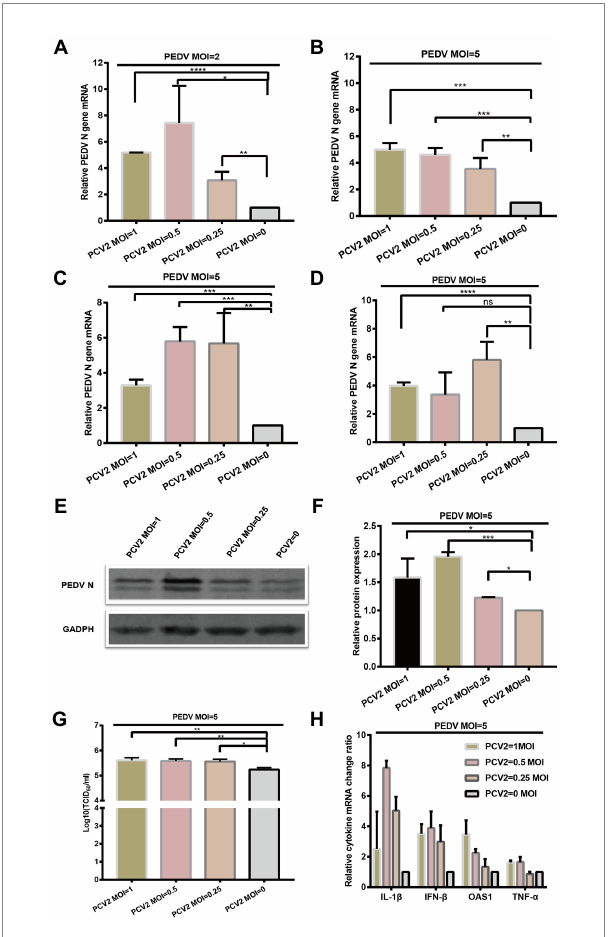
FIGURE 5 PCV2 promotes PEDV replication in IPI-FX cells. IPI-FX cells were inoculated with PEDV (MOI = 2 or 5) and simultaneously with PCV2d- LNHC (MOI = 1, 0.5, or 0.25). The cells were collected, the total RNA extracted, and the relative expression levels of nucleocapsid (N) mRNA in the PEDV–PCV2 simultaneously infected or PEDV-infected cells determined with RT–qPCR at 24 hpi (A,B) . IPI-FX cells were inoculated with PEDV (MOI = 5) and simultaneously with PCV2a-LG or PCV2b- MDJ (MOI = 1, 0.5, or 0.25). The cells were collected, the total RNA extracted, and the relative expression levels of nucleocapsid (N) mRNA in the PEDV–PCV2 simultaneously infected or PEDV-infected cells determined with RT–qPCR at 24 hpi (C,D) . IPI-FX cells were inoculated with PEDV (MOI = 5) and simultaneously with PCV2d-LNHC (MOI = 1, 0.5, or 0.25). At 24 hpi, the cells were collected, lysed, and analyzed with western blotting using the antibodies indicated on the left. GADPH was loaded as the internal control (E) . Western blotting results were quantified with ImageJ (National Institutes of Health, Bethesda, Maryland, United States) (F) . IPI-FX cells were inoculated with PEDV (MOI = 5) and simultaneously with PCV2d-LNHC (MOI = 1, 0.5, or 0.25). At 24 hpi, the cells and supernatants were freeze–thawed to obtain viral stocks. The viral titers were determined with the Reed– Muench method (G) . Relative expression levels of IL1 β , IFN- β , OASL, and TNF- α mRNAs in the PEDV–PCV2 simultaneously infected and PEDV-infected cells were also determined (H) . GADPH mRNA was used as the internal control for normalization. Means ± standard deviations were calculated from three independent replicates of each experiment (A–H) .